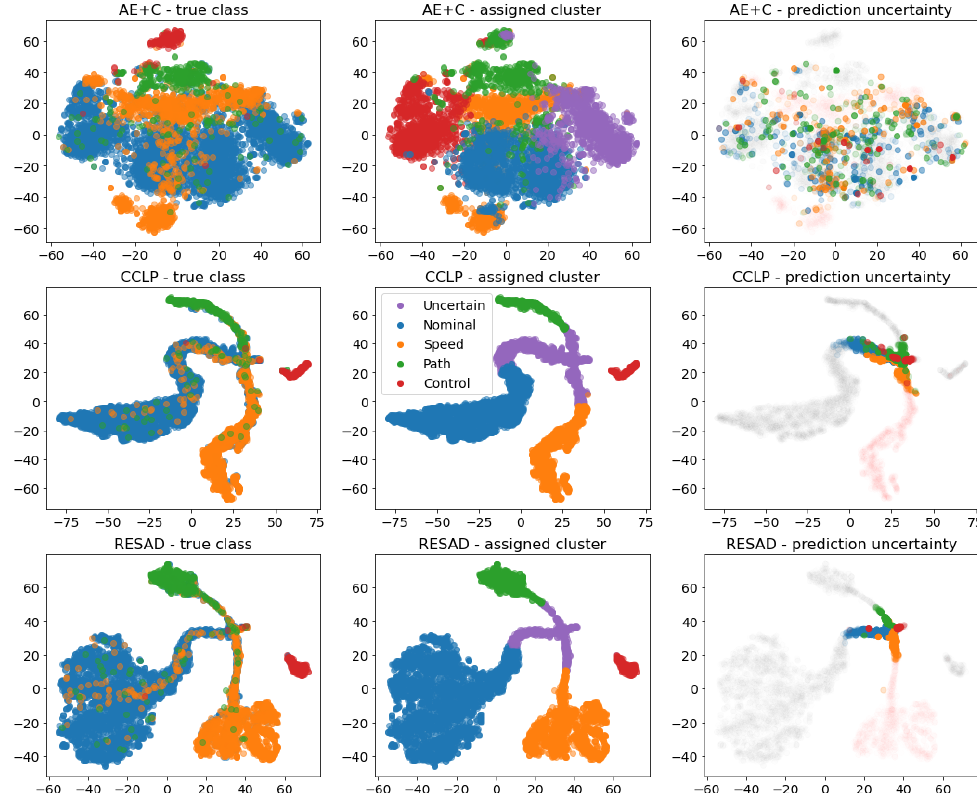
Figure 4. This figure visualizes an example of the learned latent feature space for AE+C, CCLP, and our approach. The left column is color-coded based on the actual class that each data instance belongs to, the middle column is color-coded based on the clusters found in the latent feature space, and the right column illustrates data instances that the classifier has the highest amount of uncertainty in classifying them. All plots are illustrating the 256-dimensional latent space in 2D using